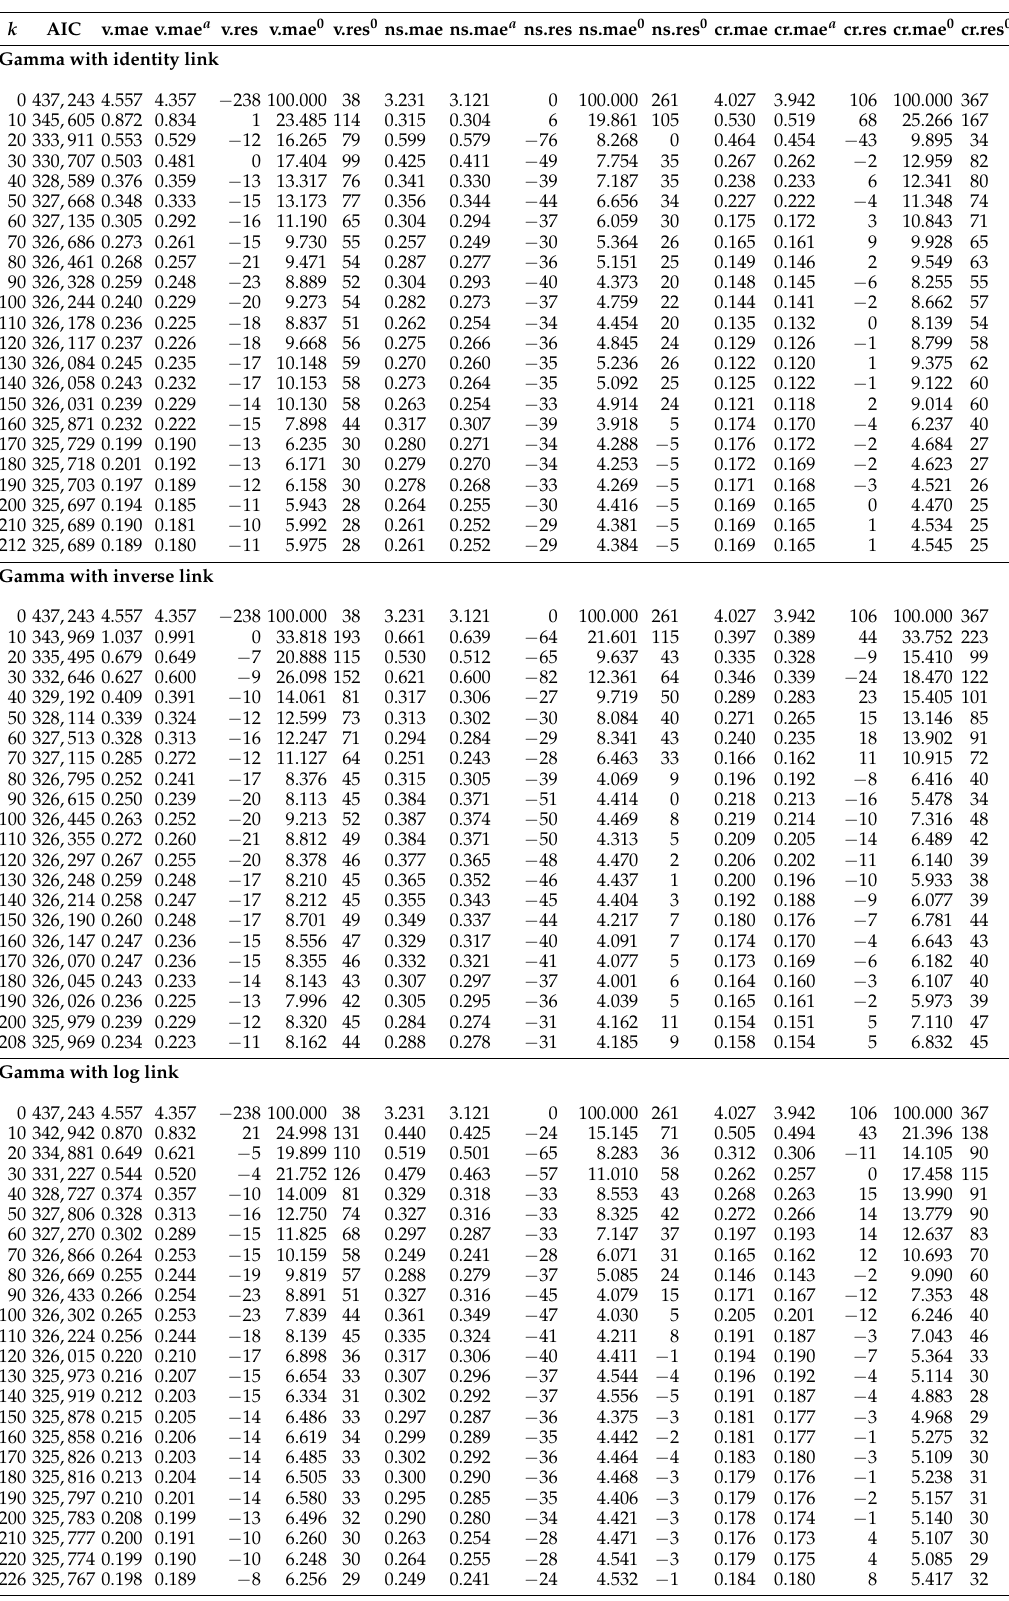
Table A12. AIC scores and out-of-sample validation figures of the gamma GLMs of BEL with identity, inverse and log link functions under 300–886 after each tenth and the final iteration.